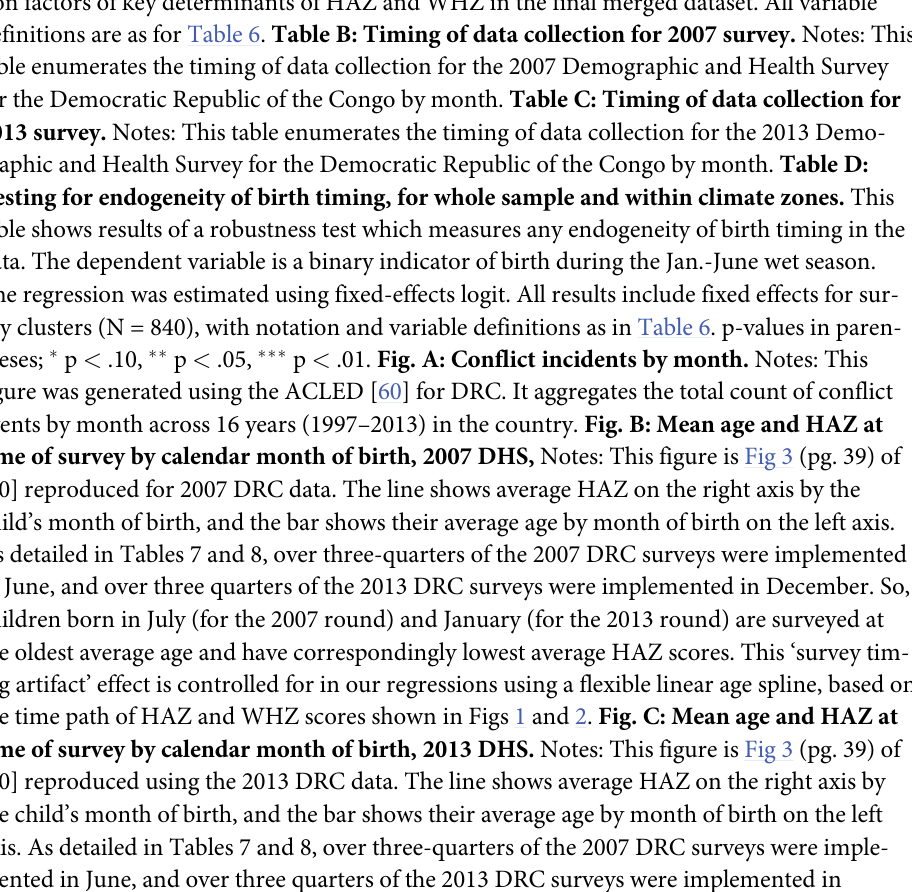
S1 File. Table A: Variance inflation factors (VIF). This table summarizes the variance infla- tion factors of key determinants of HAZ and WHZ in the final merged dataset. All variable definitions are as for Table 6. Table B: Timing of data collection for 2007 survey. Notes: This table enumerates the timing of data collection for the 2007 Demographic and Health Survey for the Democratic Republic of the Congo by month. Table C: Timing of data collection for 2013 survey. Notes: This table enumerates the timing of data collection for the 2013 Demo- graphic and Health Survey for the Democratic Republic of the Congo by month. Table D: Testing for endogeneity of birth timing, for whole sample and within climate zones. This table shows results of a robustness test which measures any endogeneity of birth timing in the data. The dependent variable is a binary indicator of birth during the Jan.-June wet